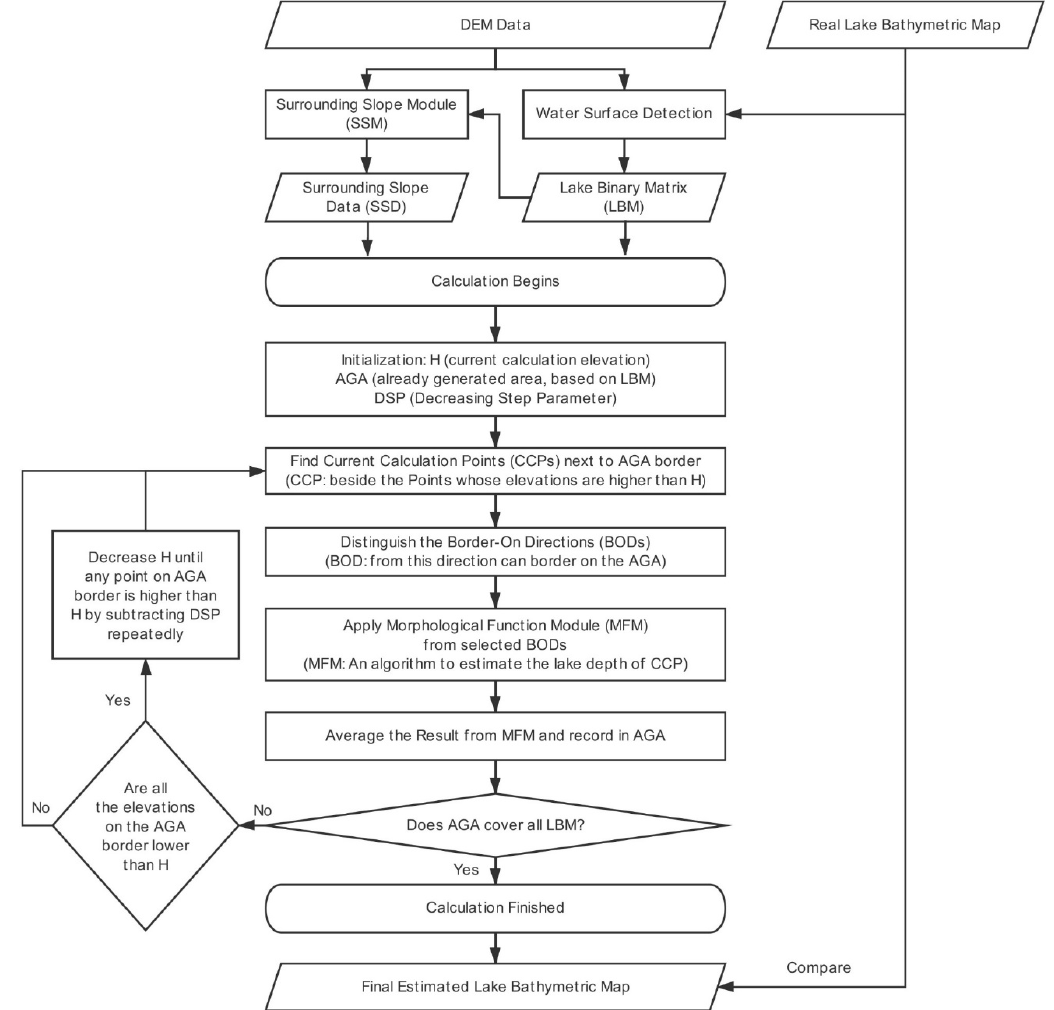
Figure 2. The flow chart of the proposed DLBM (digital lake bathymetry model).